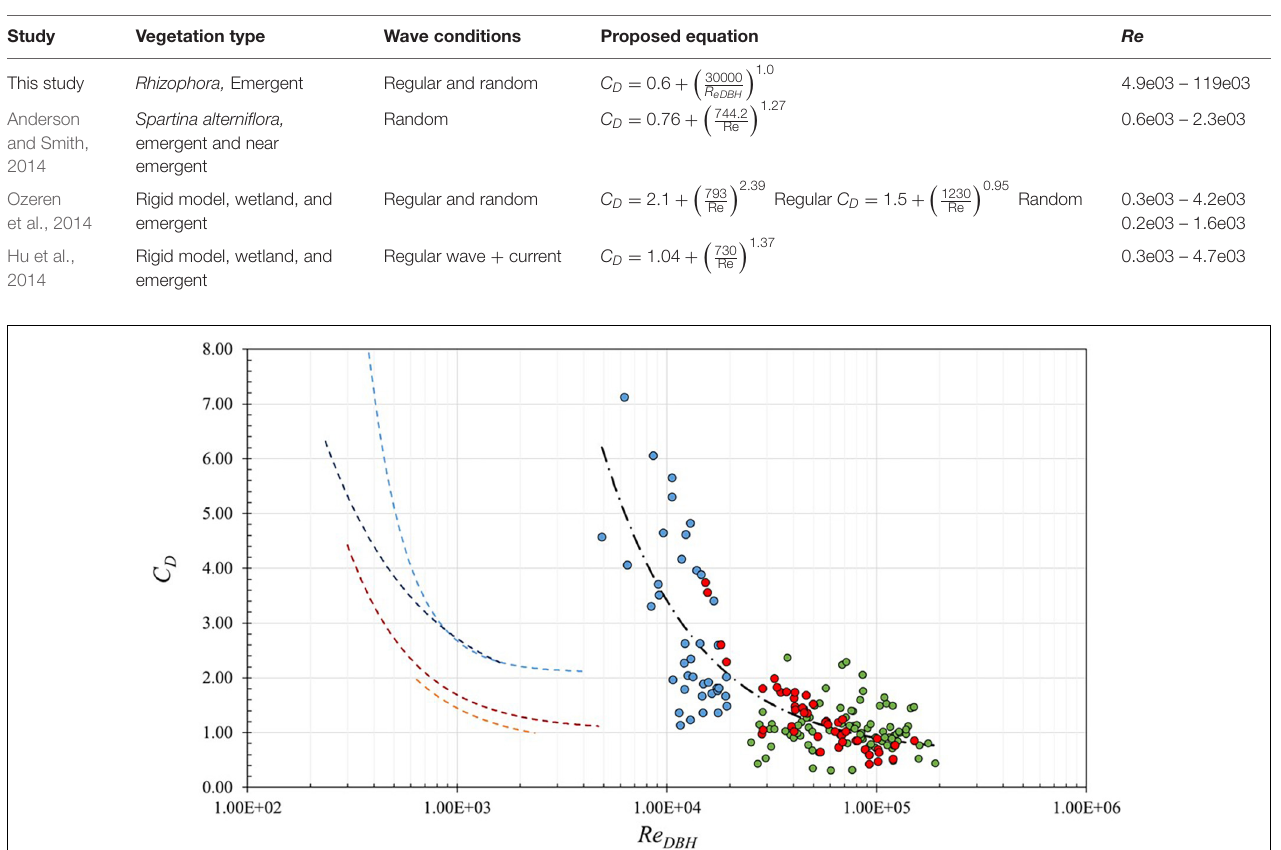
TABLE 4 | Proposed equations for drag coefficient C D as a function of the Reynolds number, Re.